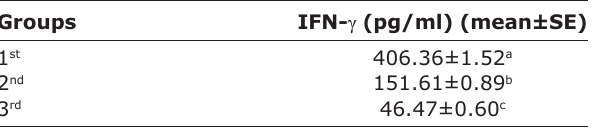
Table-2: The mean value of serum IFN- γ - 30 day PI of different mice groups immunization at 4 weeks by ELISA test.